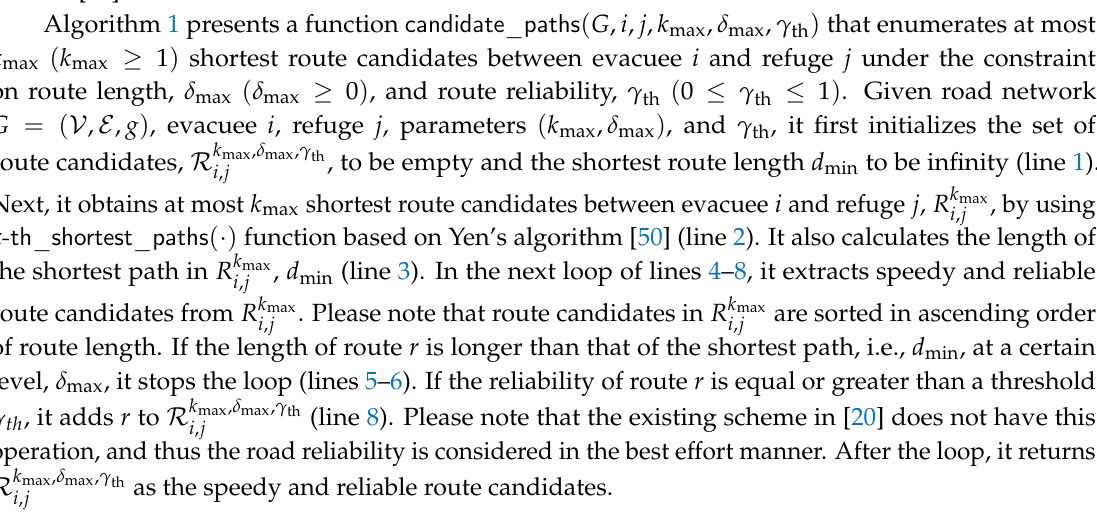
Algorithm 1 candidate_paths ( G , i , j , k max , δ max , γ th ) : Enumeration of at most k max shortest